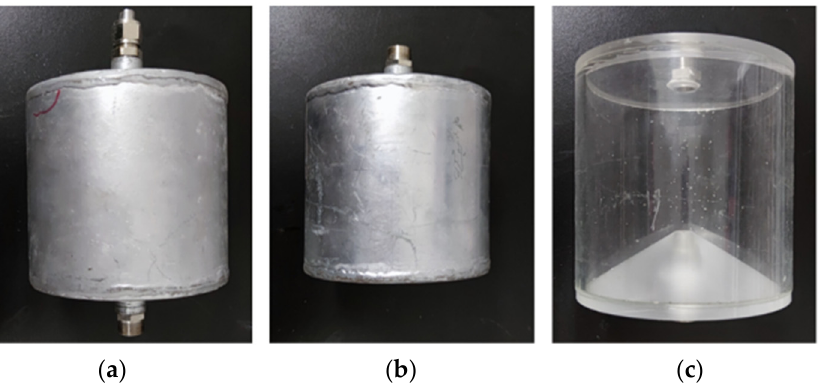
Figure 14. Different types of chambers: ( a ) traditional chamber; ( b ) end wave chamber; ( c ) Helmholtz chamber.